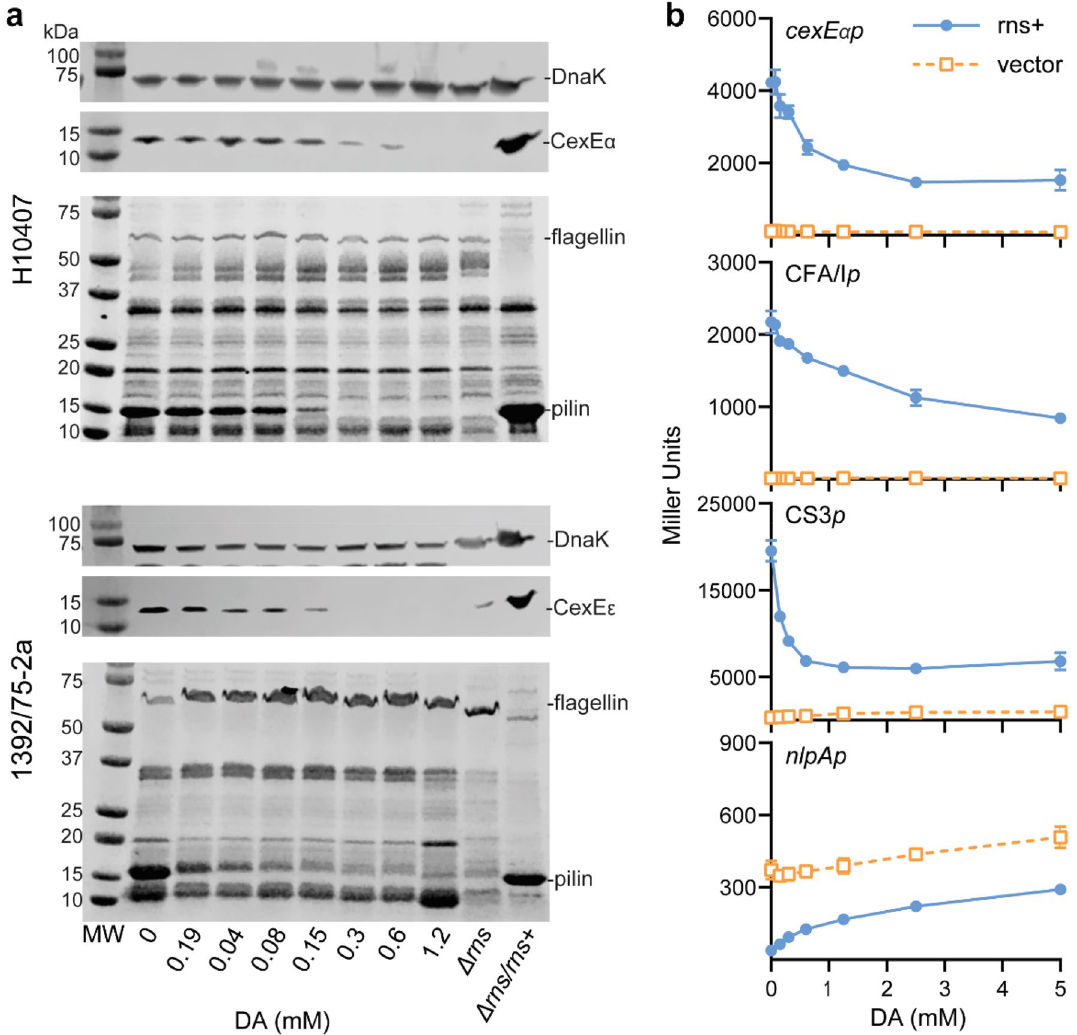
Figure 4. Decanoic acid inhibits Rns activity. ( a ) Excerpts of western blots of DnaK/CexE (same blot, probed sequentially for CexE then DnaK and cropped) and Coomassie stained pilin preparations from two ETEC strains (H10407 top and 1392/75-2a bottom). Expression of both CexE (12 kDa) and the major pilins (17 kDa) decreased with increasing concentrations of decanoic acid while DnaK (70 kDa) and flagellin (51 kDa) controls were unaffected. For full western blots see Fig. S1. ( b ) β-galactosidase assays showing decanoic acid repressed Rns activity at the cexE , CFA, and CS3 promoters and derepressed at the nlpA promoter. Data is given as the mean response ± SD, n =